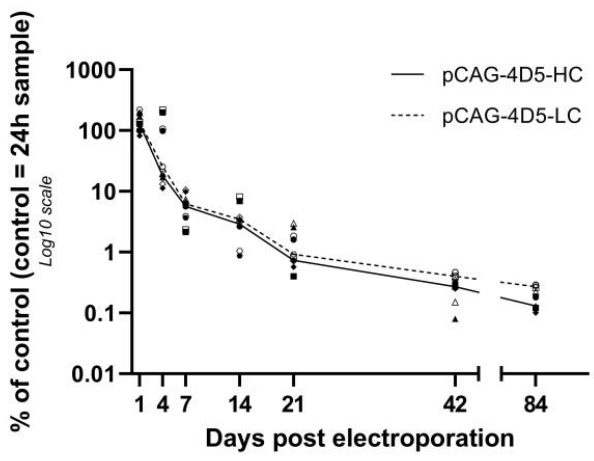
pCAG-4D5-HC, dashed line: pCAG-4D5-LC) ( n = 5, five mice per time point).